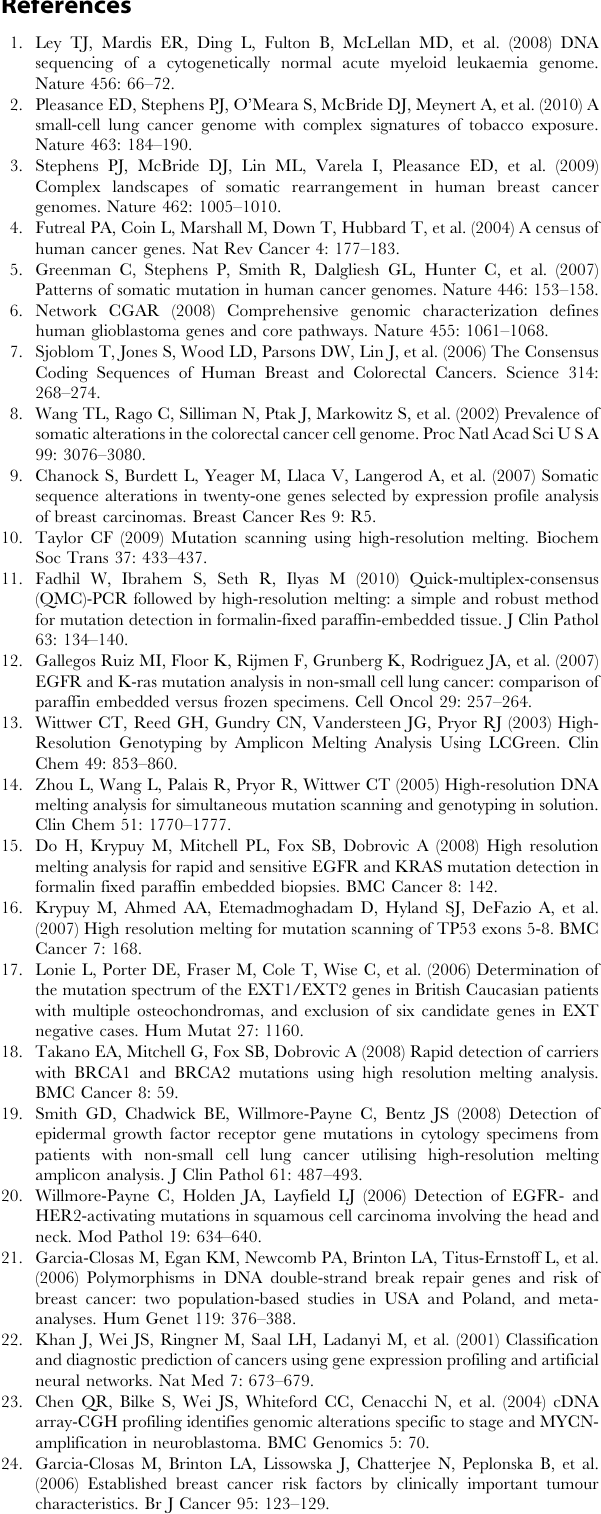
Table S2 New nucleotides changes found on the study samples submitted to dbSNP (build